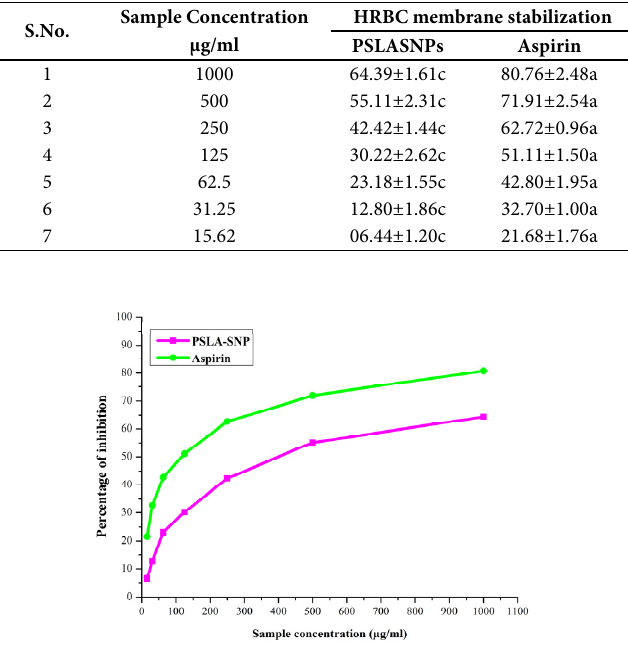
Fig. 2. Anti-inflammatory activity of PSLASNPs sample